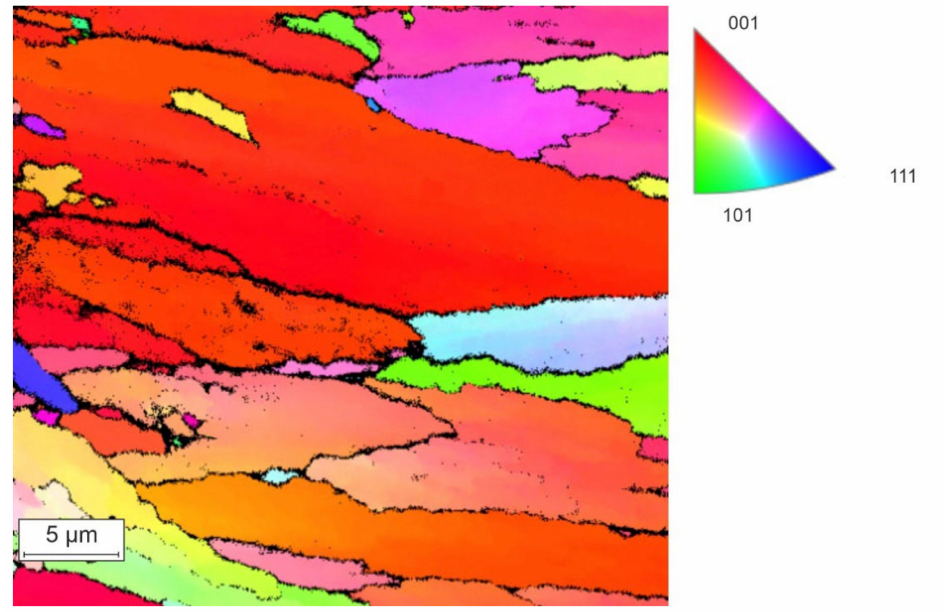
Figure 9. EBSD data of the AlSi10Mg